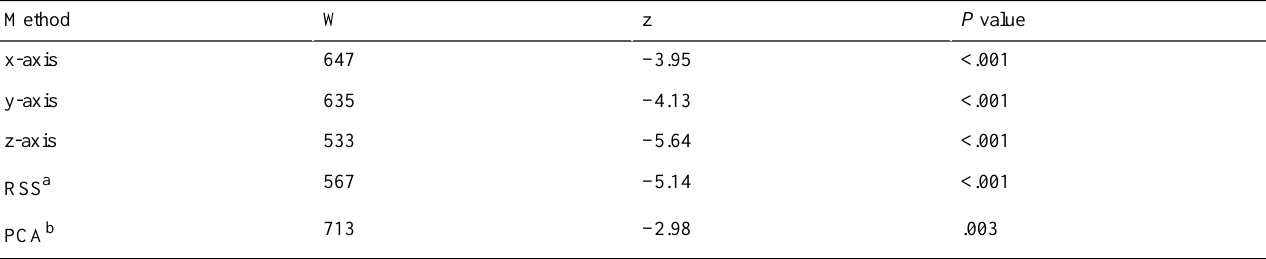
Table 1. Statistical evaluation of the calibration method using the Wilcoxon rank-sum